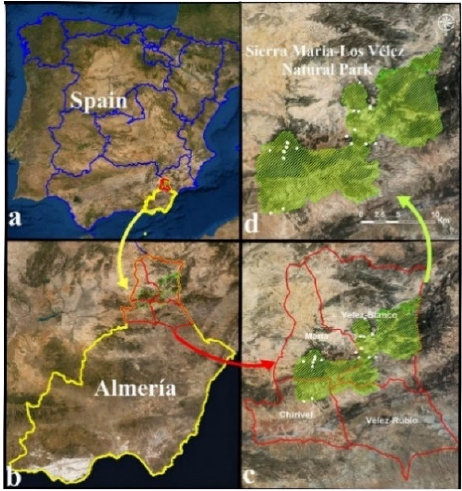
Figure 1 . Location of the study area. a) Province of Almería (Spain) in yellow. b) Region of “Los Vélez” (in red). c) Limits of the “Sierra de María-Los Vélez” Natural Park (in green). d) Reference field plots represented as white